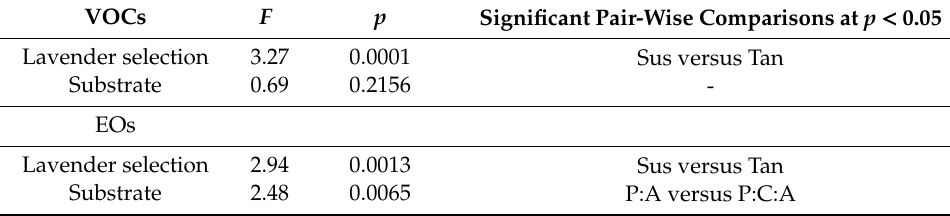
Table 4. E ff ects of lavender selection (Susa (Sus), Stura (Stu) and Tanaro (Tan)) and cultivation